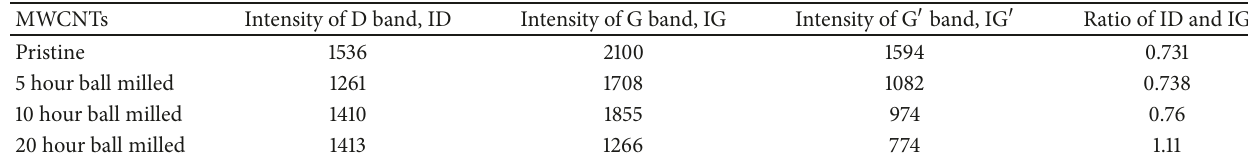
Table 2: Raman Spectra characteristics of